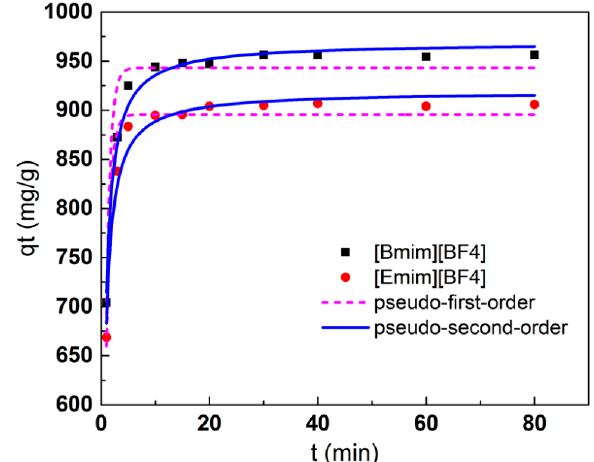
Figure 6. Pseudo-first- and pseudo-second-order kinetics for adsorption of ionic liquids ([Bmim][BF 4 ] and [Emim][BF 4 ]) onto ion-exchange resin (Amberlite IR 120Na).